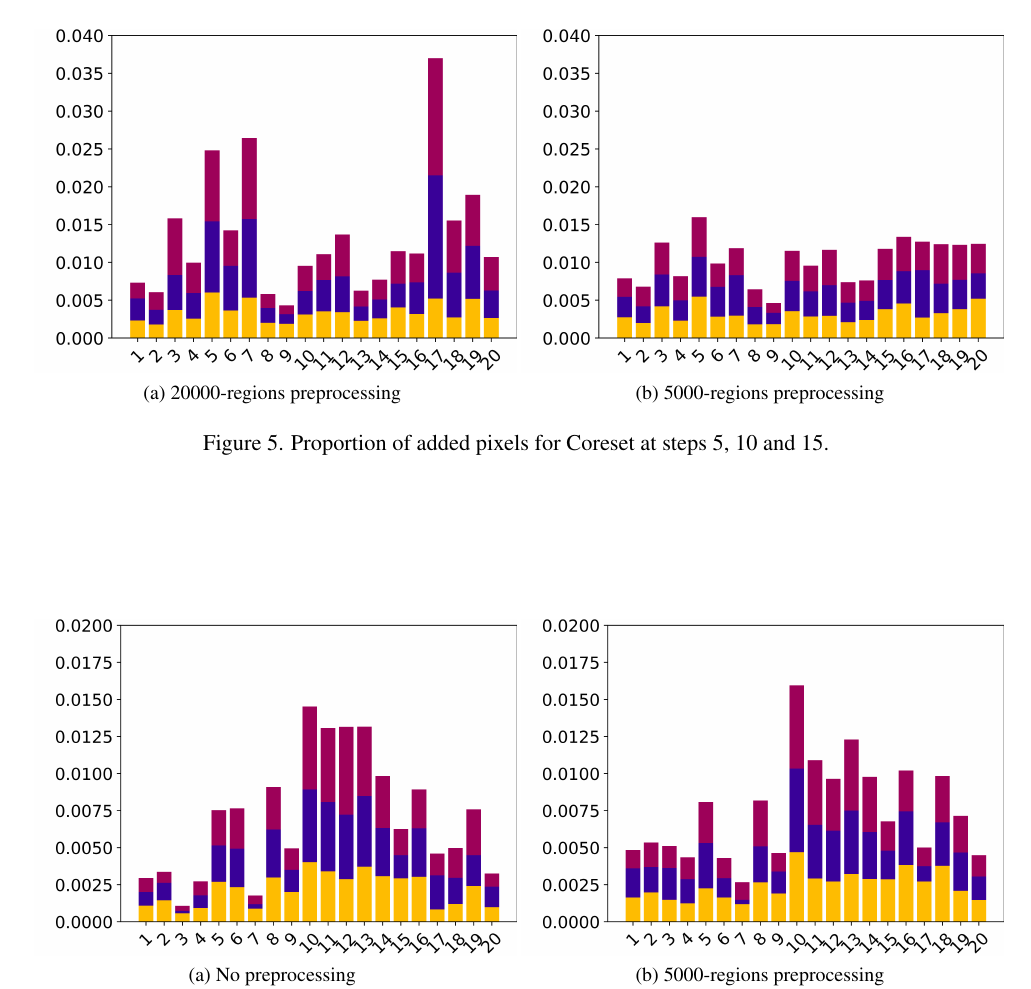
Figure 6. Proportion of added pixels for Breaking Tie at steps 5, 10 and 15.